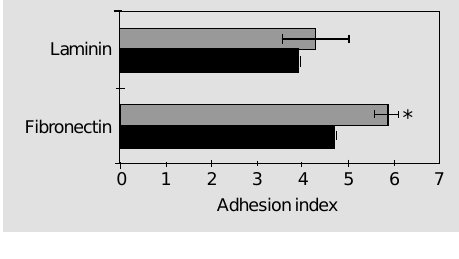
II collagen by 7% SDS-polyacryl- amide gel electrophoresis, with silver staining. Chicken CII: lane 1, 14 ng; lane 2, 20 ng; lane 3, 30 ng; lane 4, 60 ng and type VII collagen (Sigma); lane 5, 50 ng, and lane 6, 100 ng.